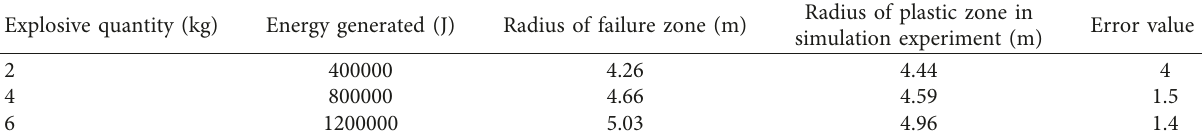
Table 4: Calculation results of the coal rock power system.